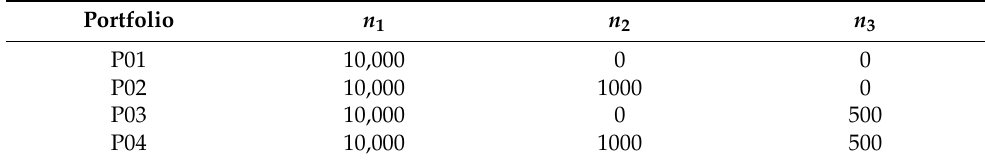
Table 9. Portfolio